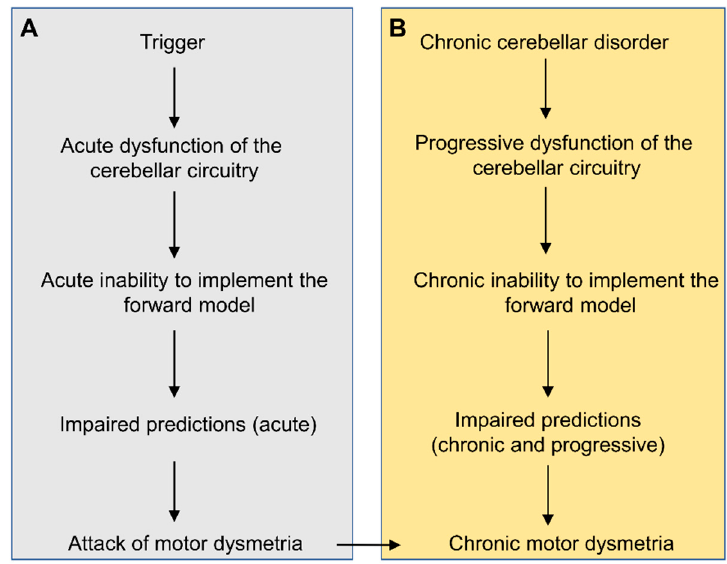
Figure 9. General framework on the mechanism of motor dysmetria in episodic ataxias ( A ) and in chronic cerebellar ataxias ( B ). ( A ): attacks of ataxia may be triggered by external events (exercise, emotions, or startle) in a context of channelopathy. The triggers induce an acute dysfunction of the cerebellar circuitry, resulting in impaired forward models causing motor ataxia. ( B ): in chronic cerebellar disorders, the degenerative process a ff ecting the cerebellar cortex and / or the cerebellar nuclei leads to chronic dysfunction of microcircuits. Predictions cannot be computed accurately.